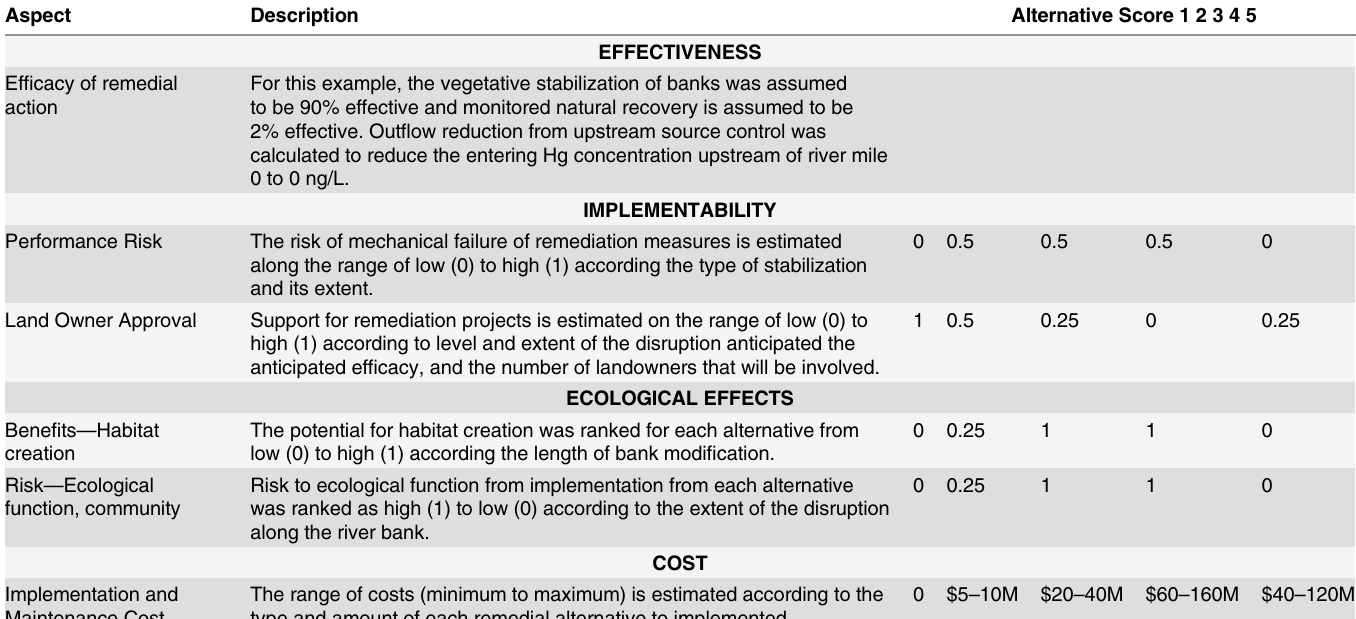
Table 1. Initial performance of each remedial alternative on the evaluation